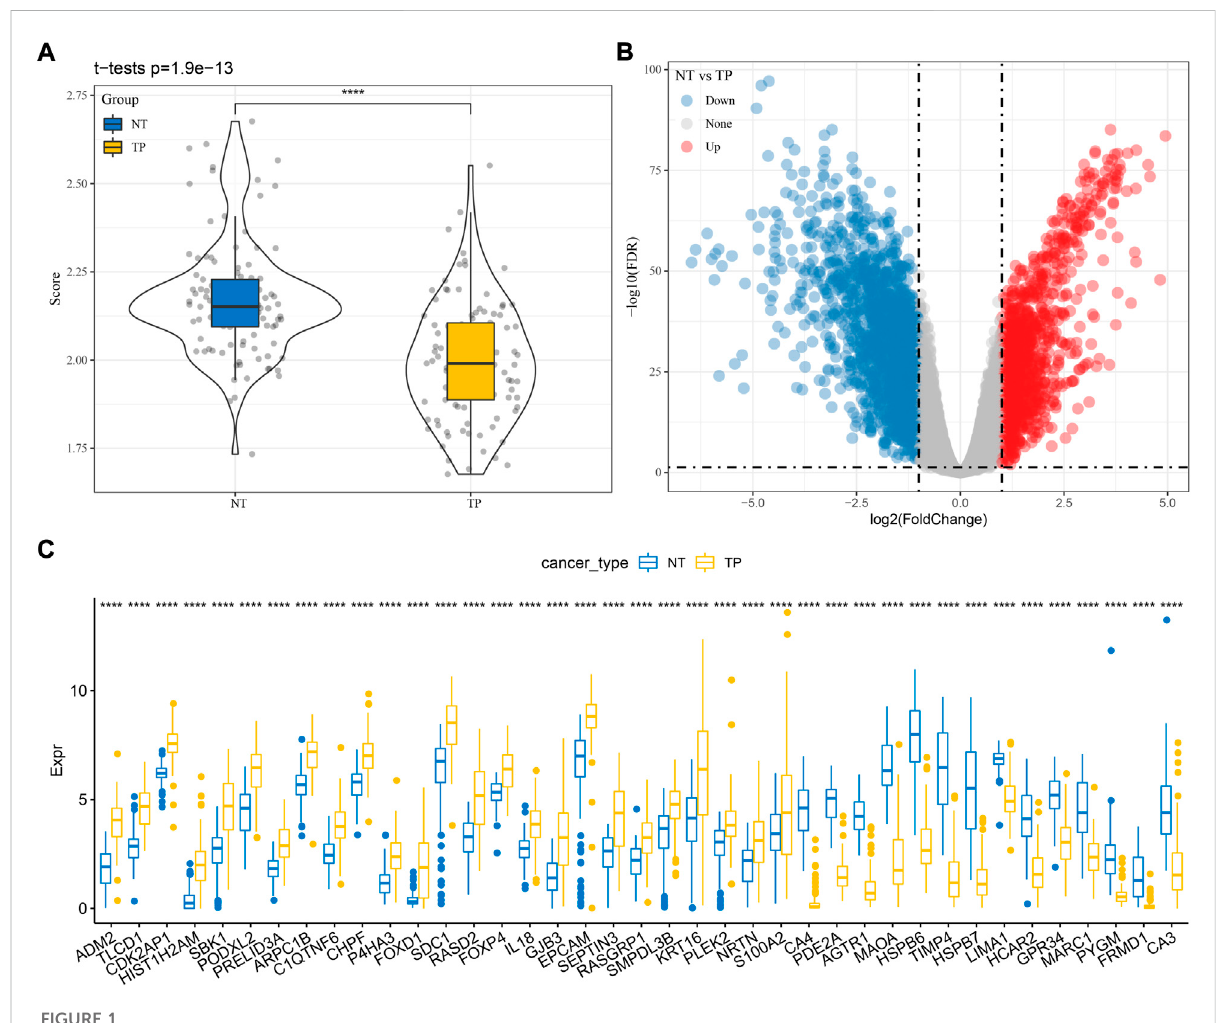
FIGURE 1 Identi fi cation of cuproptosis-associated genes related to TNBC prognosis in TCGA dataset. (A) The ssGSEA score of cuproptosis in paracancerous (NT) and tumor samples (TP). (B) Volcano plot of DEGs between NT and TP samples. (C) The expression of seven prognostic cuproptosis-associated genes in NT and TP samples. Student t test was performed. **** p <